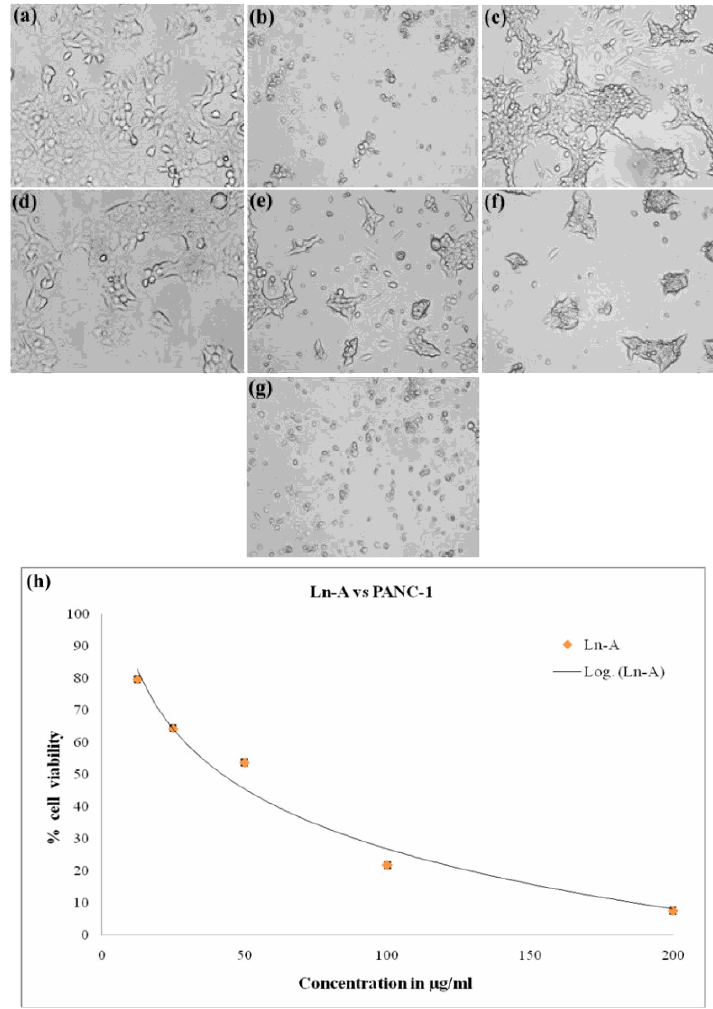
Figure 12. Anticancer assay of different concentration of biosynthesized LnFb-AgNPs from L. nepetifolia flower bud extract: ( a ) negative control, ( b ) positive control, ( c ) 12.5 μ g/mL, ( d ) 25 μ g/mL, ( e ) 50 μ g/mL, ( f ) 100 μ g/mL, and ( g ) 200 μ g/mL. ( h ) Graphical representation showing comparative % of cell viability.